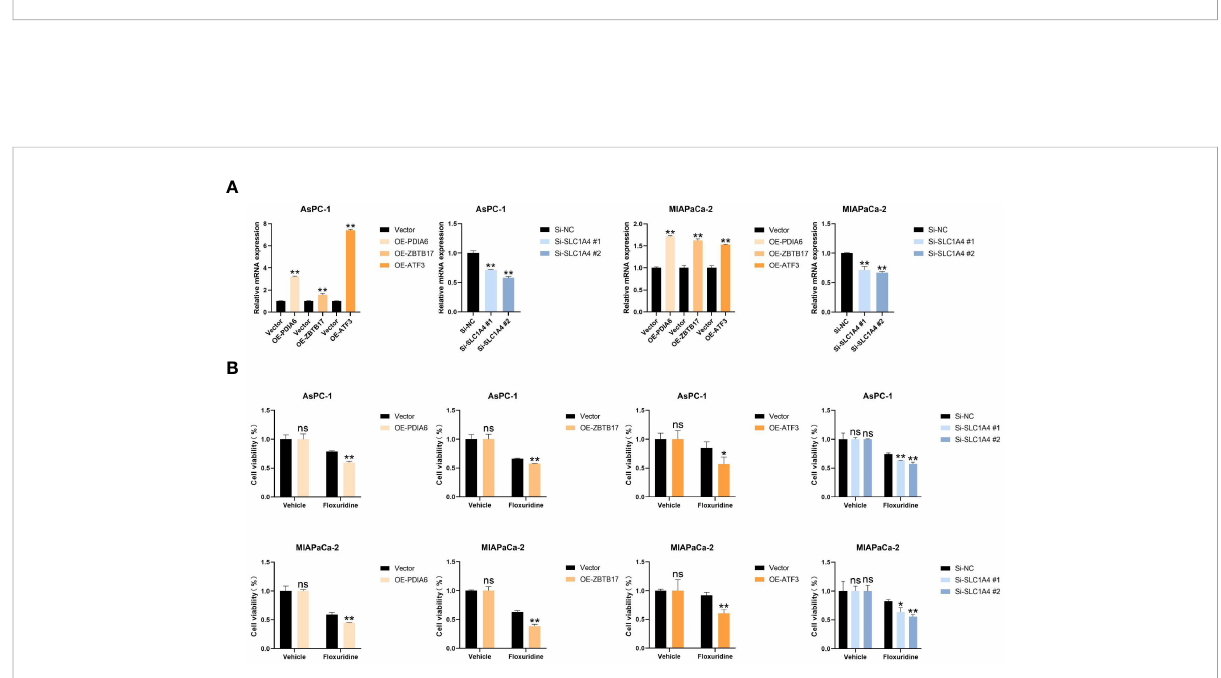
FIGURE 11 Cell proliferation assay. (A) Real-time RT ‒ PCR analysis of the mRNA levels of PDIA6, ZBTB17, ATF3, and SLC1A4 in the indicated cells. (B) Cell viability assay of the indicated cells treated with fl oxuridine. *P<0.05, **P<0.01. and ns=not signi fi cantly different (p >